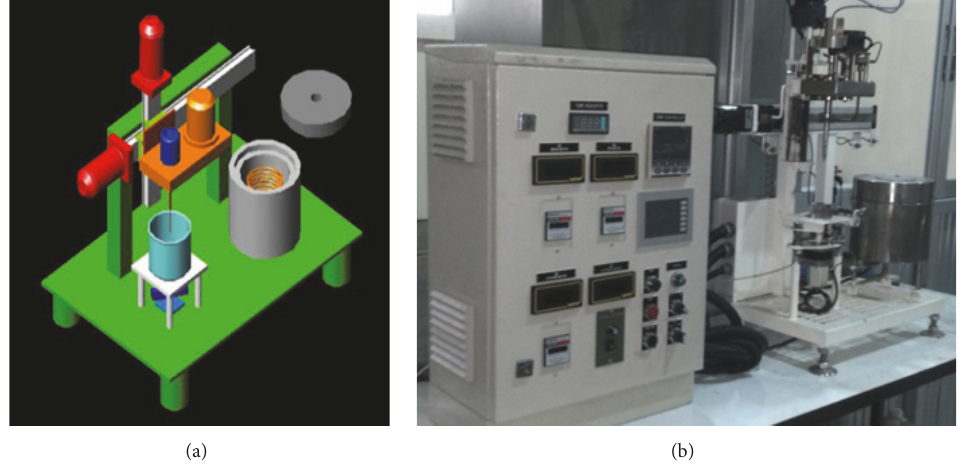
Figure 1: (a) Schematic diagram and (b) actual prototype of the dip-spin coating